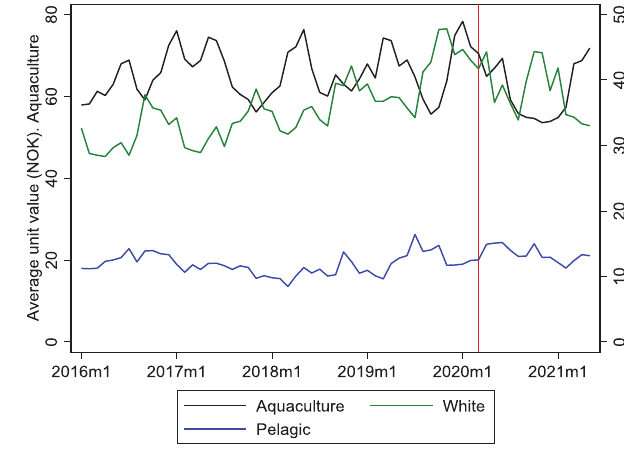
Fig. 3. Monthly unit prices in NOK/kg. January 2016 – May